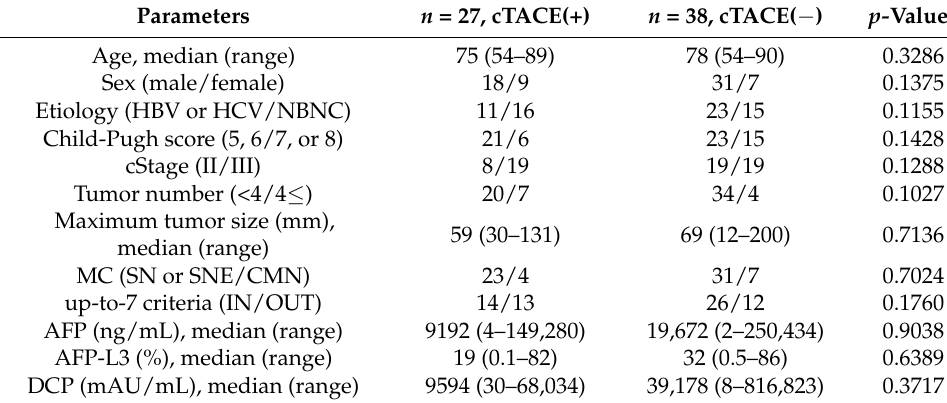
Table 1. Baseline characteristics of the patients examined in the study.